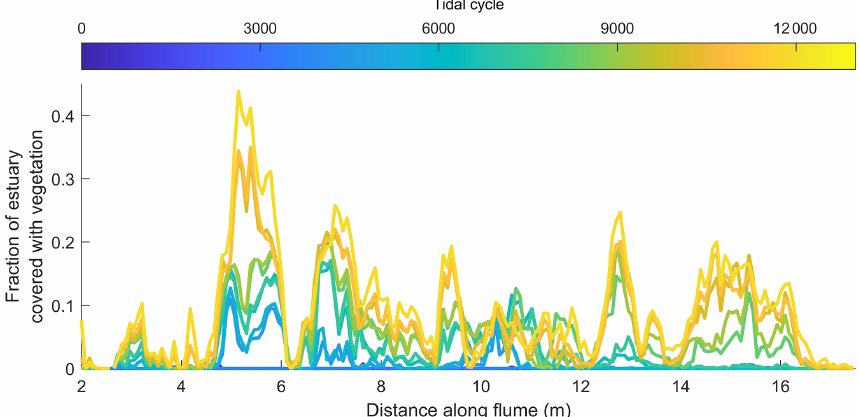
Figure 12. Development of vegetation cover as a fraction of estuary width along the